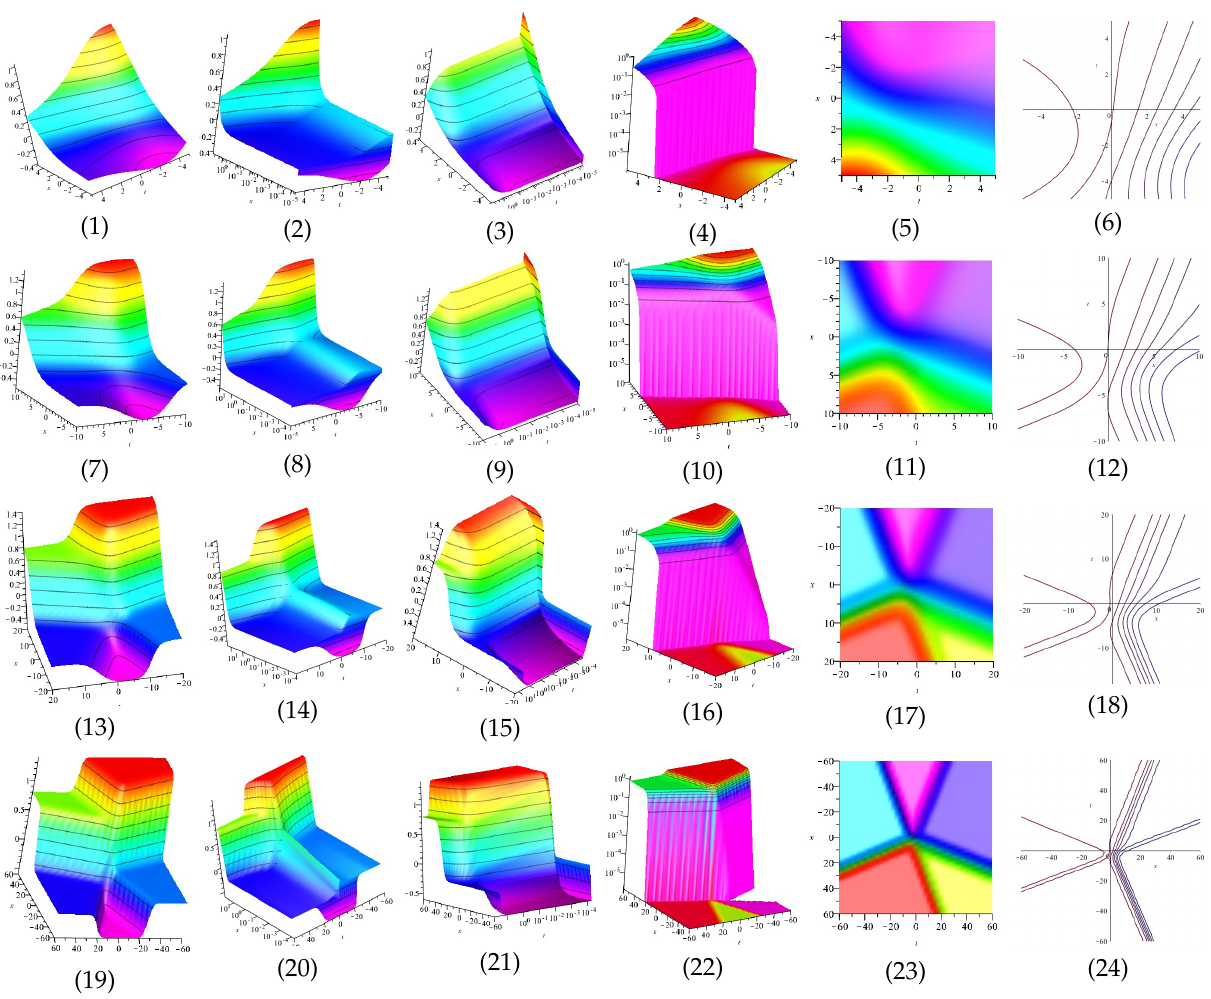
Figure 6. The 3D and 2D with the diagram of u 3,2 , in four different domains, in four differ- ent domains, for R 1 = − 0.50, R 2 = − 0.70, S 1 = 0.20, S 2 = 0.70, S 3 = − 0.30, and A 3 =